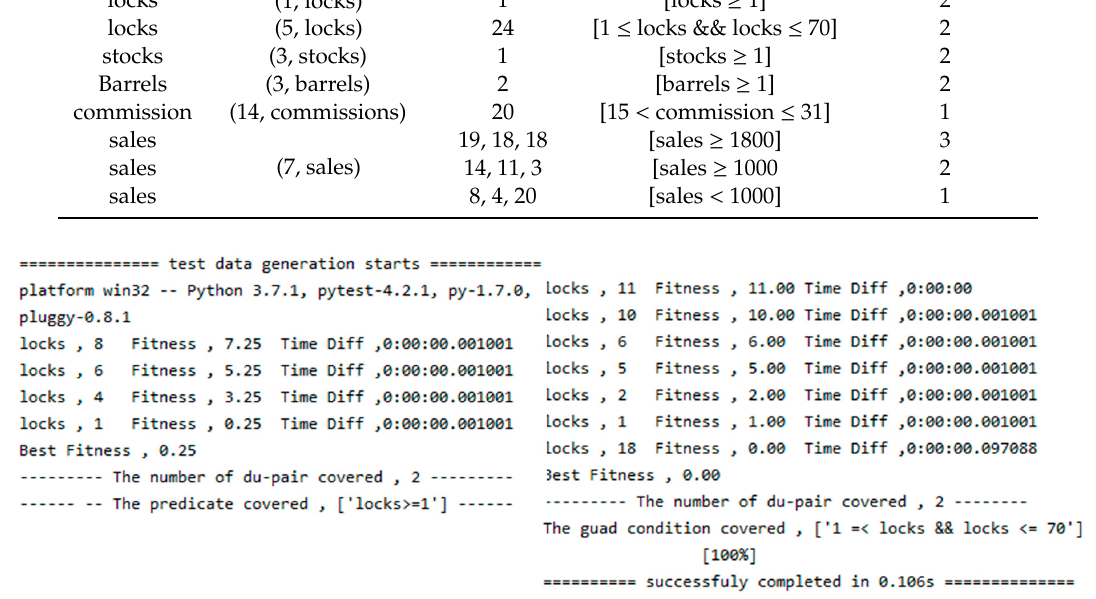
Figure 4. Snapshot of the test data generated for variable locks.